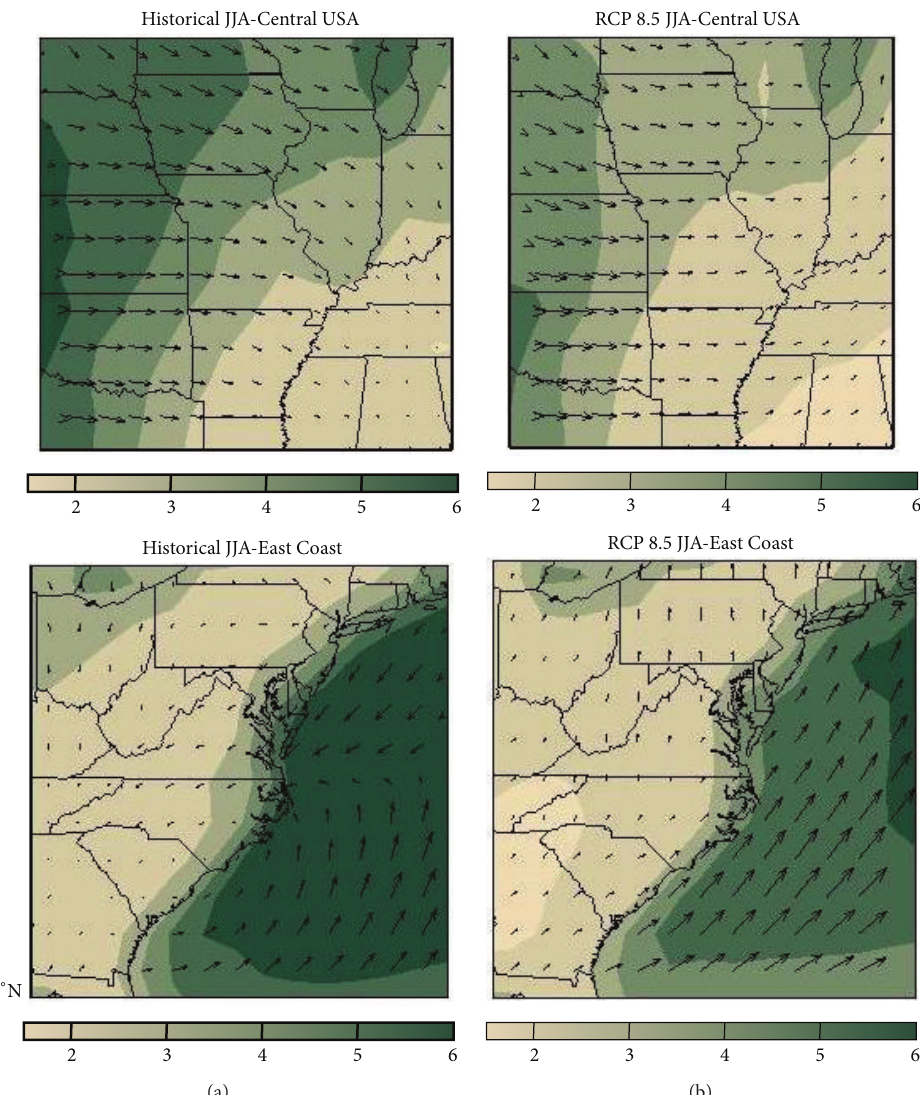
Figure 6: Detailed maps of the 10m velocity fields for selected regions from the EC-Earth model simulations in CMIP5. (a) shows the 20th century historical runs and (b) the 21st century RCP 8.5 runs. Both are the average over the last two decades of the respective runs, and over summer (JJA) only. Top: Central United States. Bottom: the East Coast of the United States. The arrows indicate the climatological wind field and the color shading indicates the magnitude of the wind vectors shown. The color scale for the latter, in m/s, is shown at the